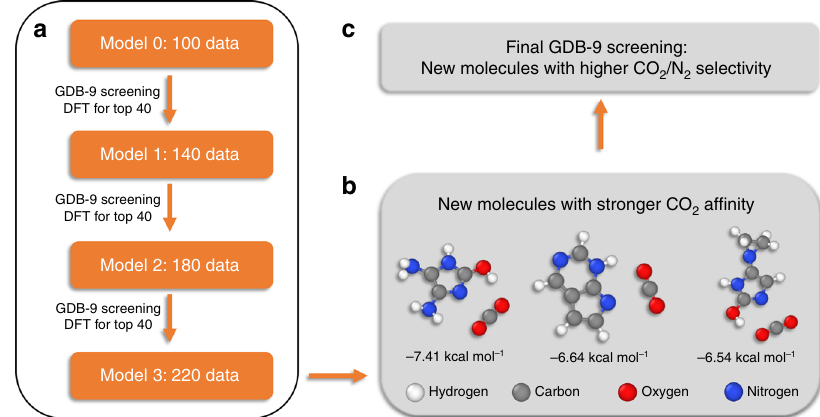
Fig. 4 Flowchart of the intermediate steps followed for the high-throughput computational screening of the GDB-9 database. a The three active- learning steps starting from a model with 100 molecules (Model 0), b the results obtained from DFT, and c the screening of the GDB-9